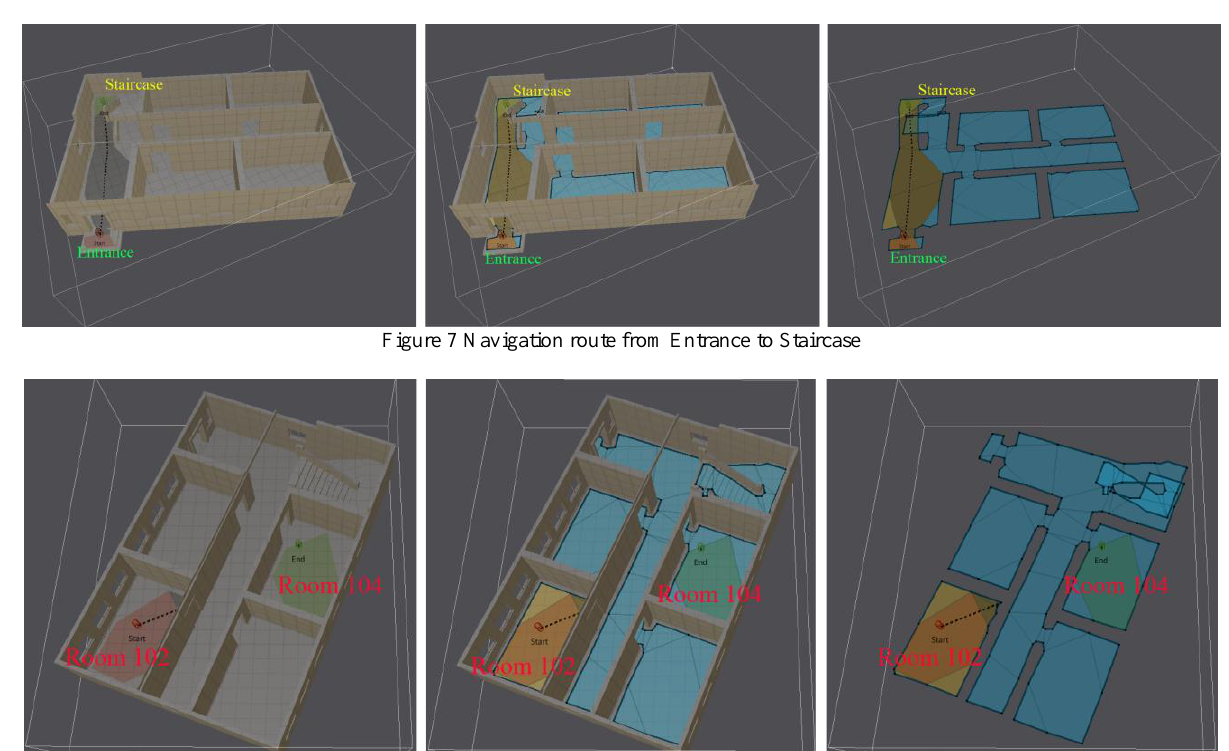
Figure 6 Navigation route from Gatehouse to Room 103